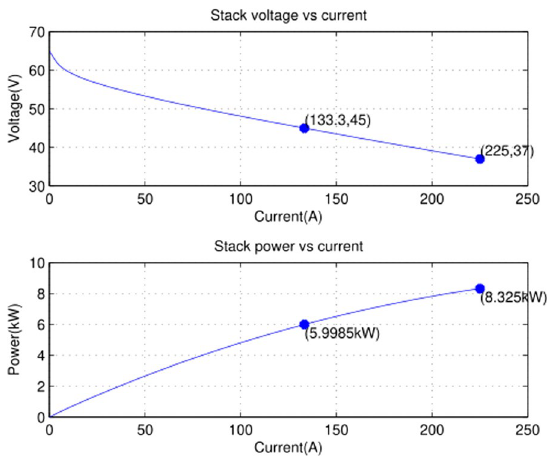
Fig. 8 Fuel cell V–I characteristics and output power curve